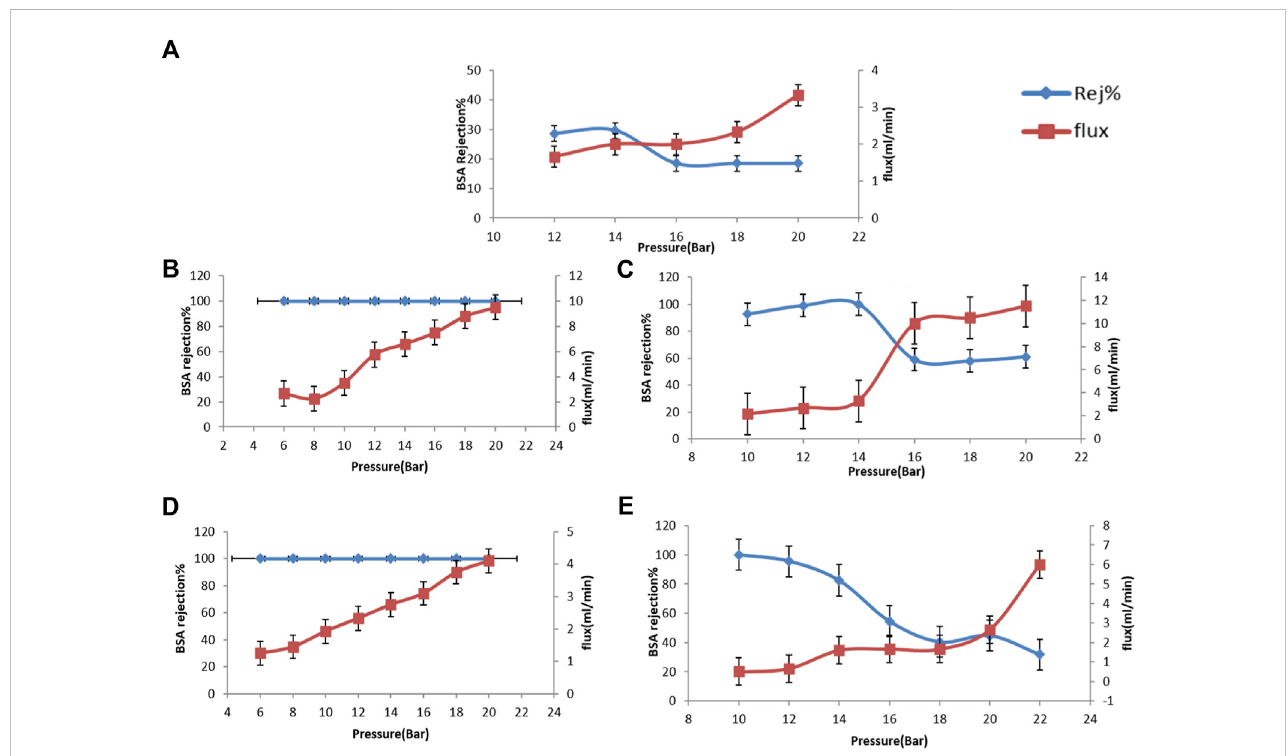
FIGURE 7 Rejection % and permeate fl ux of prepared cellulose acetate nanocomposite membranes, (A) neat CA, (B) CA/0.05 bent, (C) CA/0.1 bent, (D) CA/ 0.05 TiO 2 and (E) CA/0.1 TiO 2